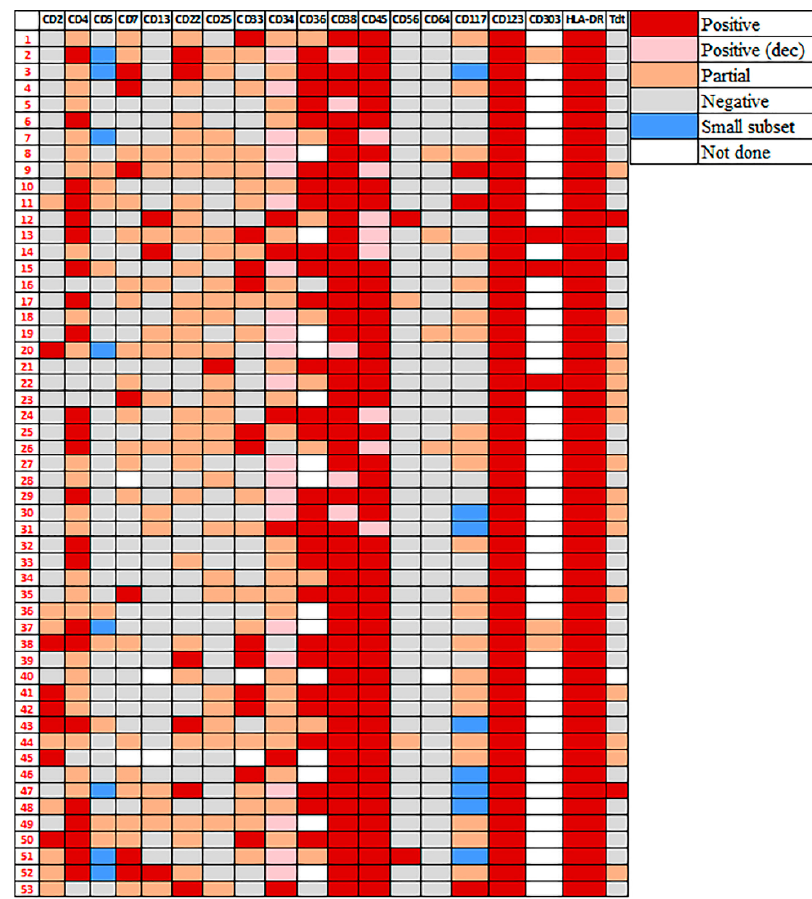
Figure 2. The immunophenotype of pDCs in pDC-AML by flow cytometry. The detailed immunophenotype of 53 cases of pDC-AML is displayed (cases # 1–34, RUNX1 mutated; cases # 35–53, RUNX1 wild type). For the category of positive (dec), CD34 expression was compared to the coexisting myeloblasts; CD38 and CD45 expression was compared to normal/reactive pDCs. Of note, similar to positive category, positive (dec) cases also showed >80% cells being positive.